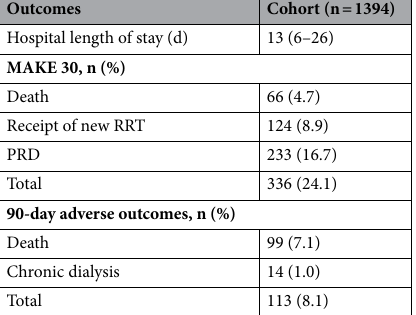
Table 2. Outcomes of the study cohort. MAKE30, Major Adverse Kidney Events within 30 days. Continuous variables are presented as median (interquartile range) and categorical variables are presented as n (%). RRT renal replacement therapy, PRD persistent renal dysfunction.